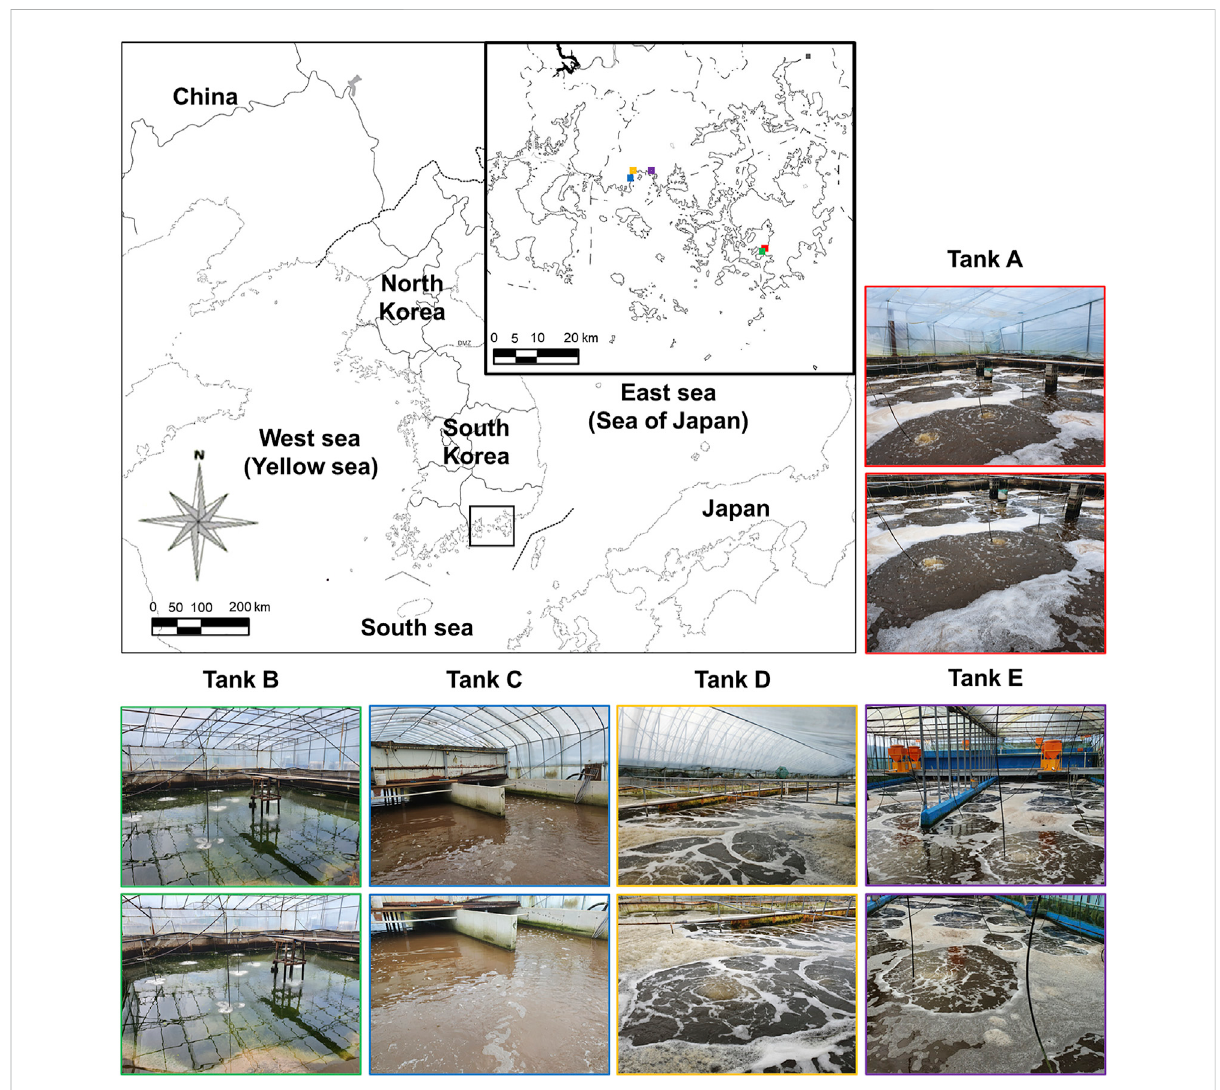
FIGURE 1 SamplingsitesonthesoutherncoastoftheKoreanPeninsula.Thelocationofthe Litopenaeusvannamei shrimpfarmsusingbio fl octechnology is indicated by the black box. Additionally, locations (colored squares on the main map) and images of tanks A (red boxes), B (green boxes), C (blue boxes), D (orange boxes), and E (purple boxes) are indicated. For exact tank locations, see Section